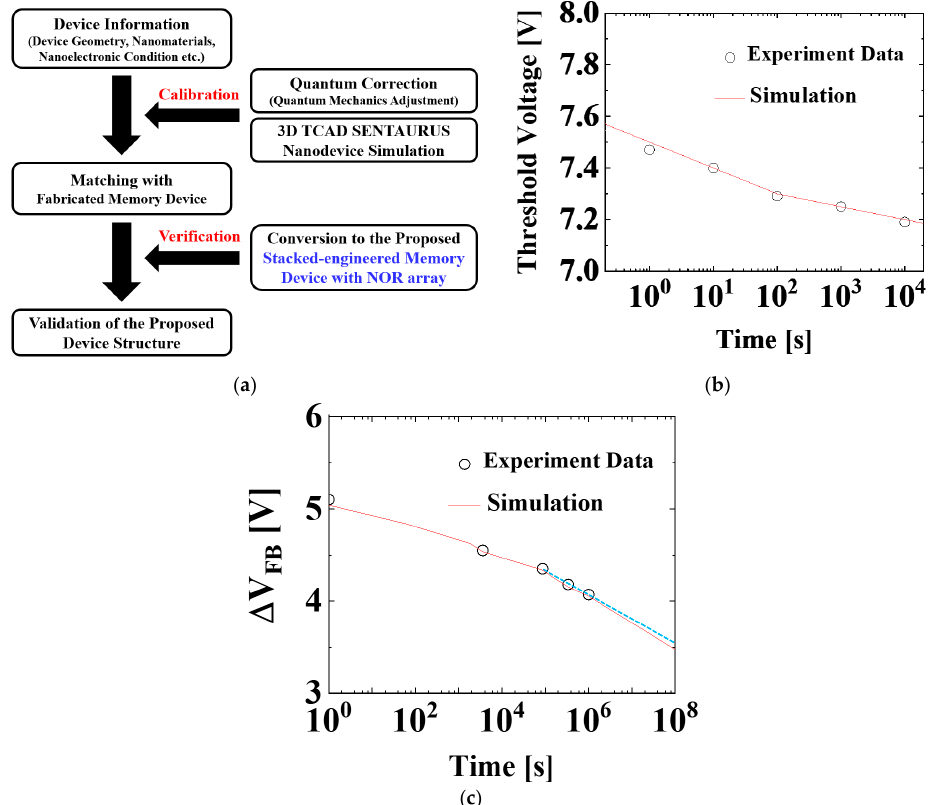
Figure 2. ( a ) Illustration that summarizes overall workflow of this paper; ( b ) calibration results based on the fabricated TANOS device [45]; ( c ) another calibration result based on fabricated BE-TAHOS device [46]. (Sky blue dot line indicates the linear approximation of retention characteristic in the fabricated BE-TAHOS device.).